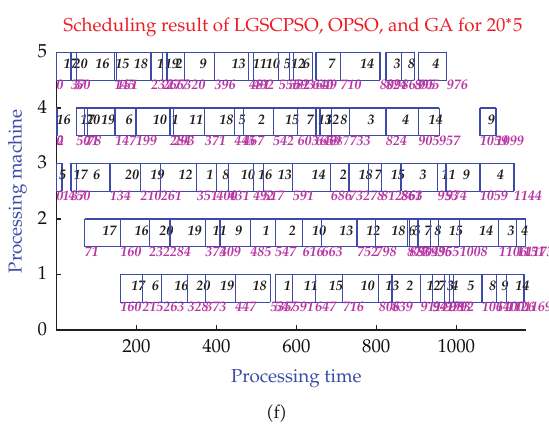
Figure 1: Convergence figure and GANTT of OPSO, GA, and LGSCPSOA for